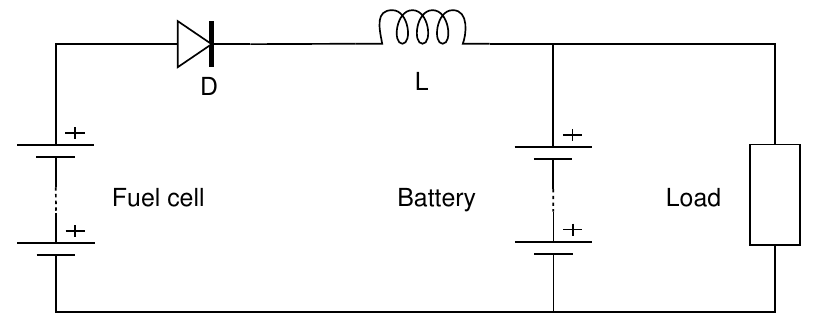
Figure 5. Electric circuit schematic of a passive hybrid power